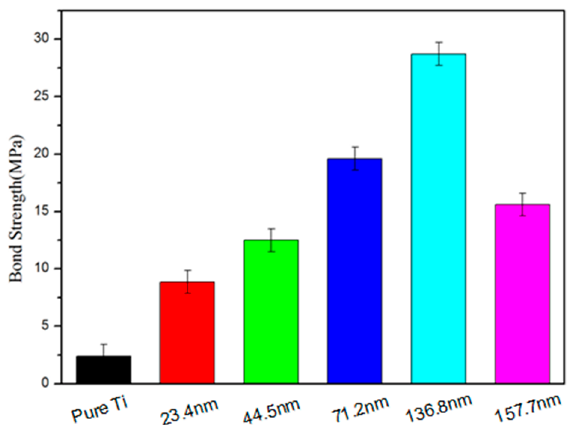
Figure 7. The bond strength of HA coatings on TiO 2 nanotubes with different inner diameters.